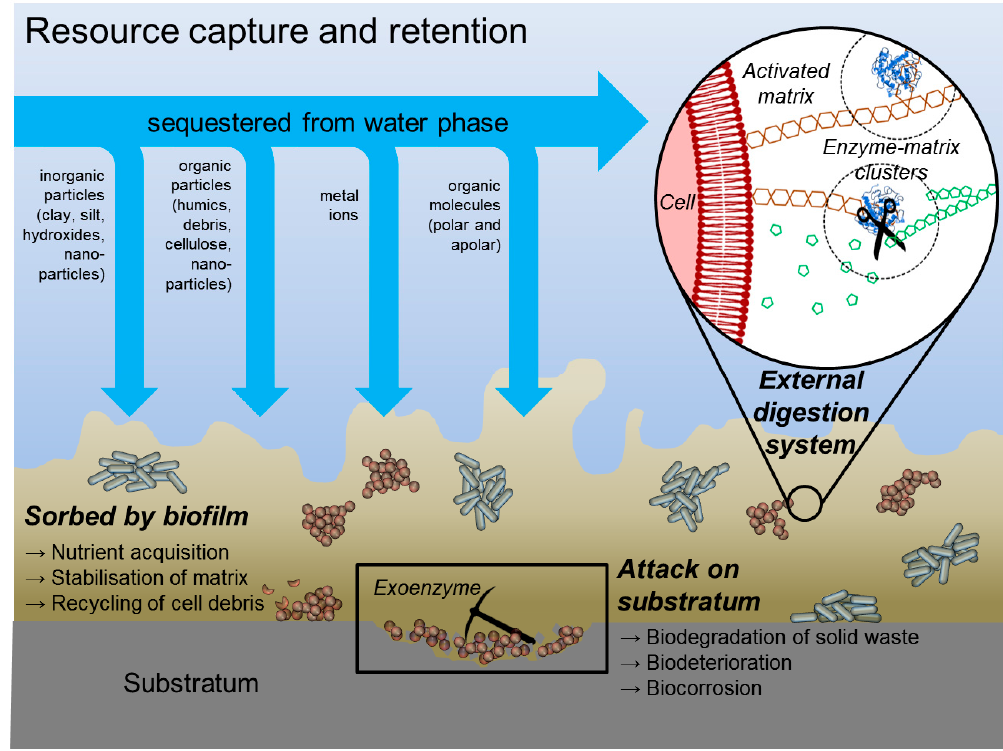
Figure 2. Resource caption and retention by and in biofilms. The biofilm is a sponge-like system that